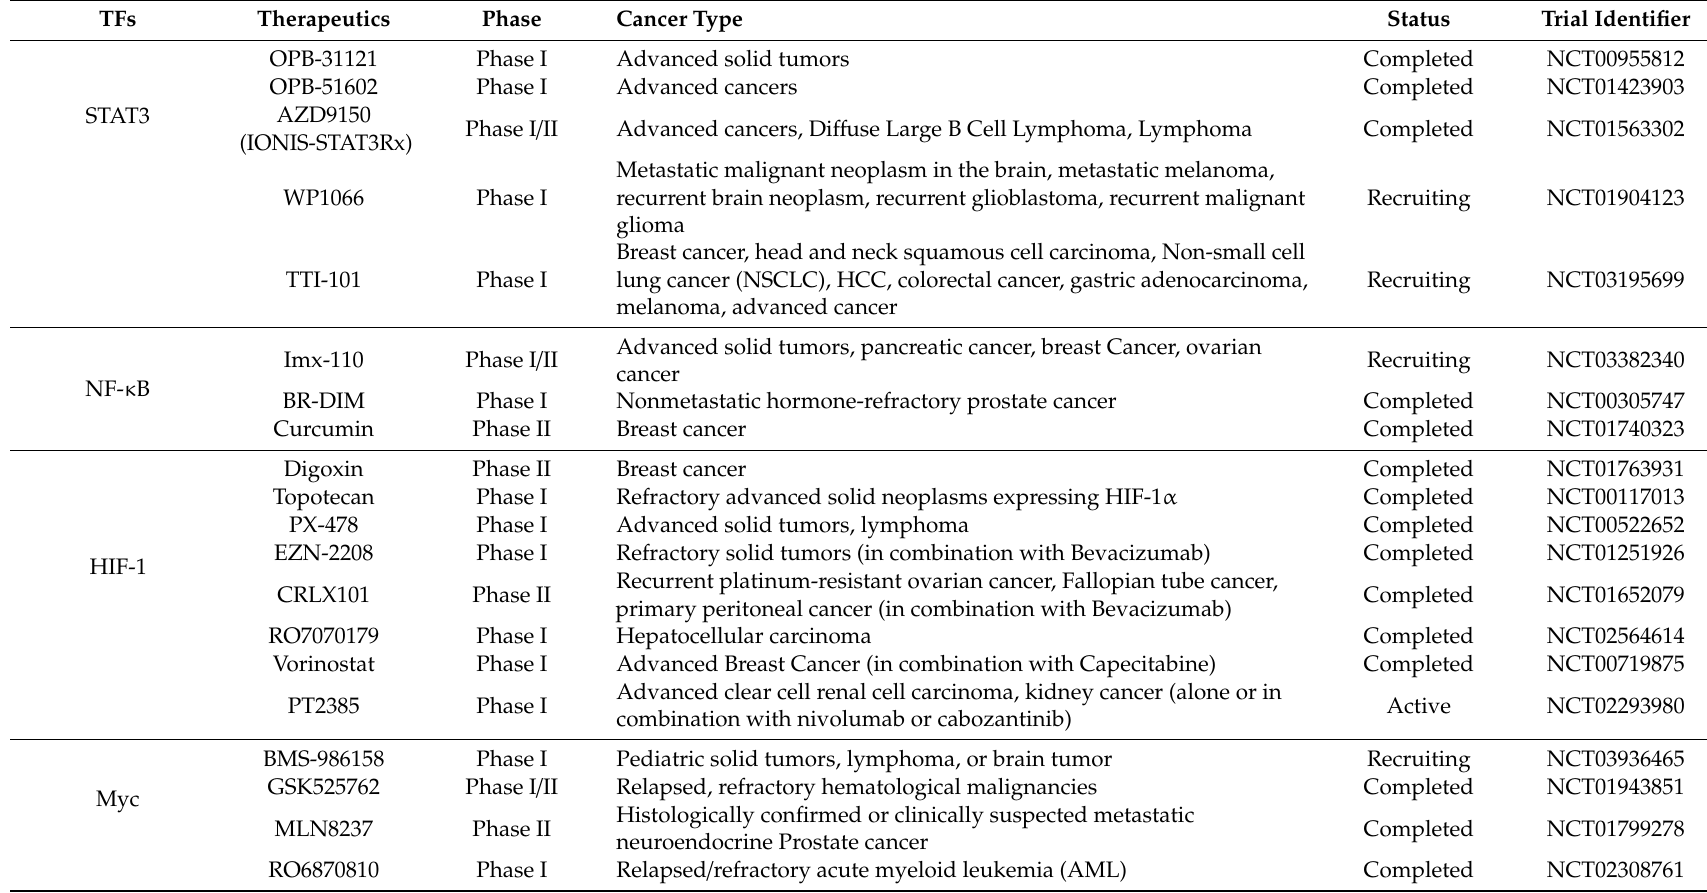
Table 2. Selected Inhibitors against Transcription Factors (TFs) in Clinical